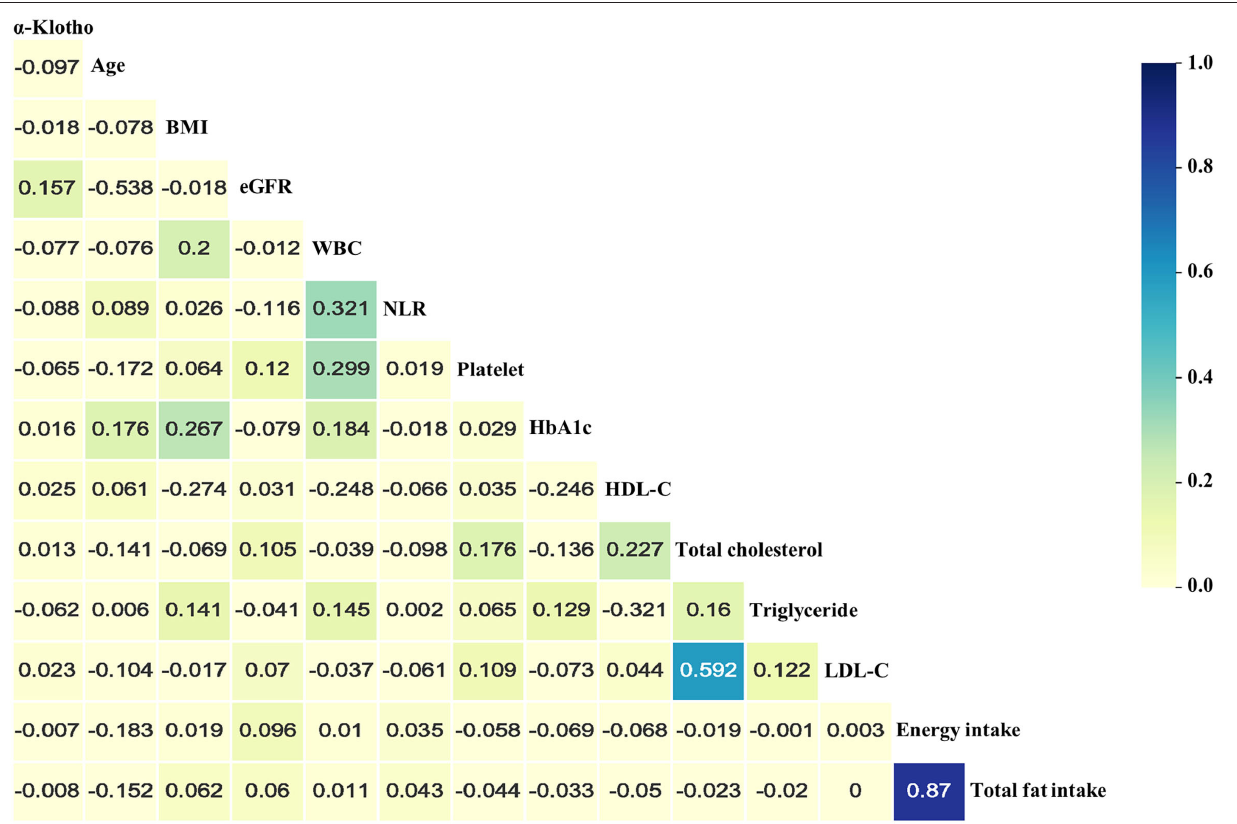
FIGURE 2 | Heatmap of the correlations between serum soluble α -Klotho and baseline continuous variables using Spearman correlation analysis. Absolute value of “ r ” over 0.02 was significantly correlated. BMI, body mass index; eGFR, estimated glomerular filtration rate; WBC, white blood cell; NLR, neutrophil-to-lymphocyte ratio; HbA1c, glycated hemoglobin; HDL-C, high-density lipoprotein cholesterol; TC, total cholesterol; LDL-C, low-density lipoprotein cholesterol.